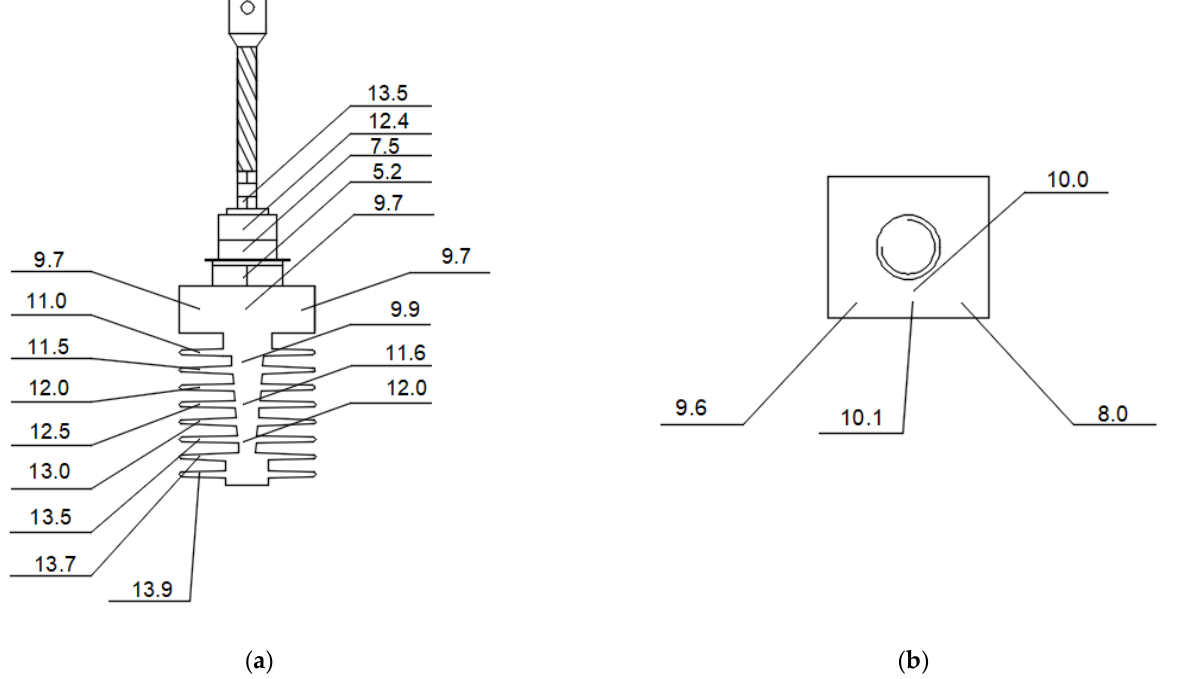
Figure 18. Differences ( T j – T s ) between the junction temperature ( T j ) and the surface temperatures ( T S ) (from Tables 6 and 7) at points presented in Figure 2 for a power of P j = 28.80 W: ( a ) side view; ( b ) top view.